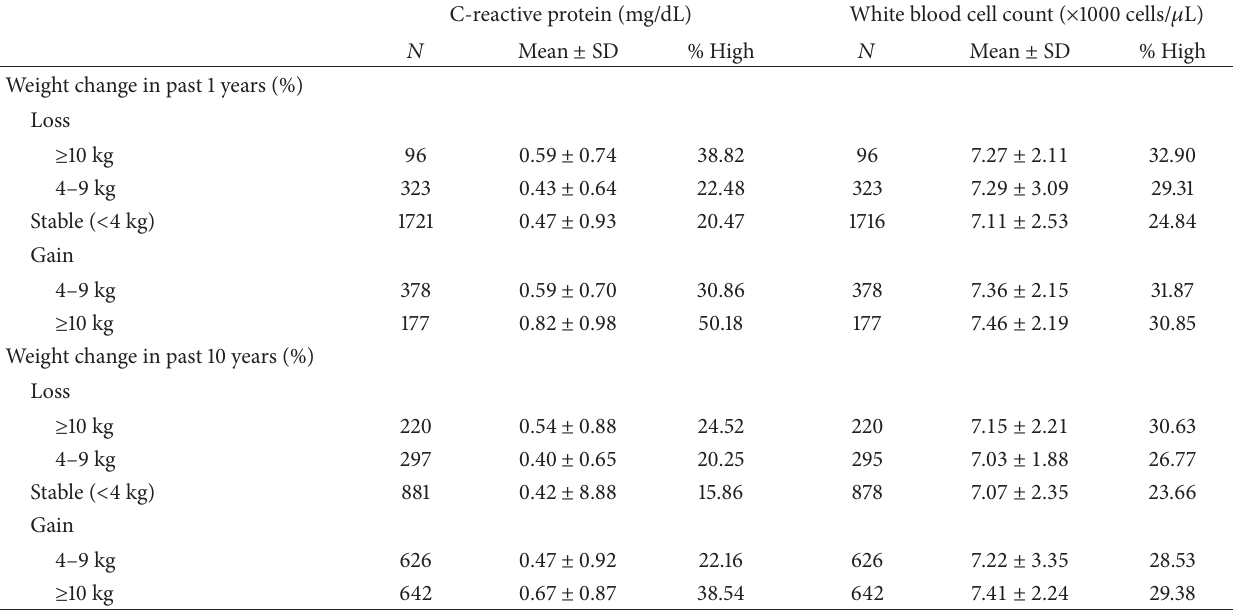
∗ High levels included individuals in the highest sample-based quartile (CRP > 0.51mg/dL; WBC > 8.1 × 1000 cells/ 𝜇